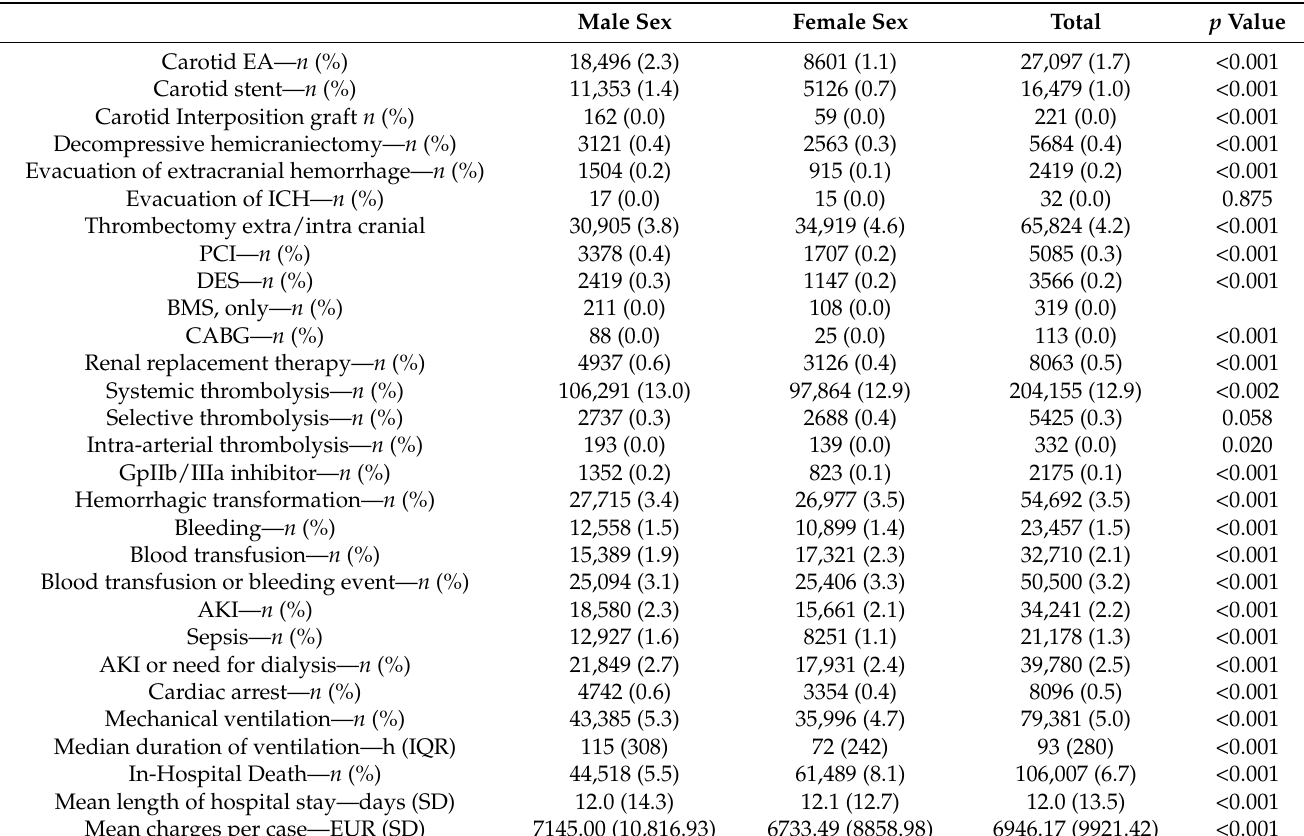
Table 2. In-patient treatment and complications. Ischemic cerebral infarction female vs. male sex from 2014 to 2019. Male Sex Female Sex Total p